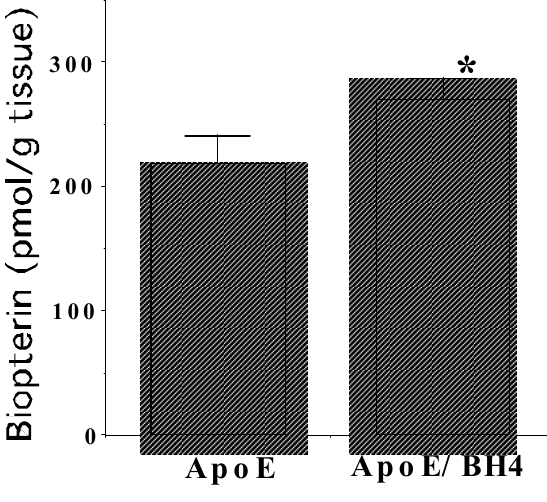
Figure 1. Total biopterin in the aortas of ApoE- KO/BH and ApoE-KO mice. (*P < 0.05; n = 4